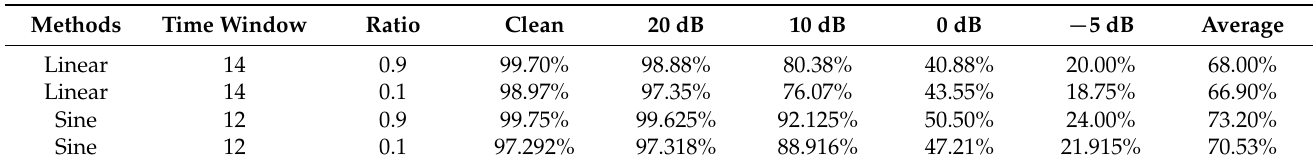
Table 9. The performance of the proposed SNNs under different mapping methods with different training set proportions.